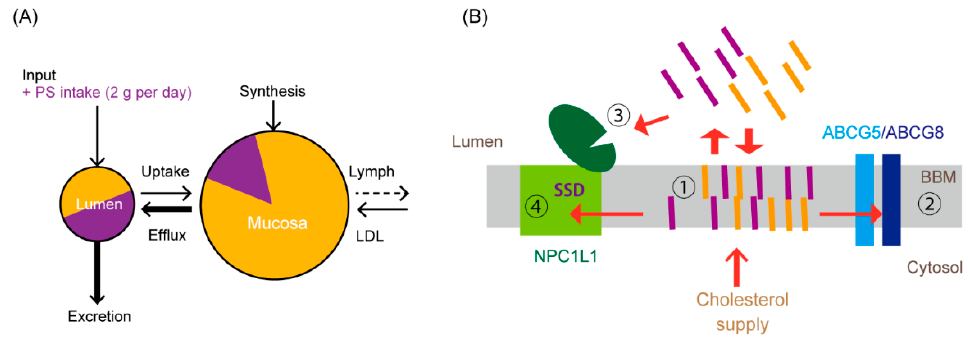
Figure 5. ( A ) Changes in cholesterol flux with plant sterol/stanol (PS) intake are shown in a simplified open compartment model in Figure 1F. Two grams of PS per day, which is recommended to reduce circulating LDL-C, could predominate in luminal sterols and is incorporated into the BBM (Mucosa). Lumen indicates the ratio of cholesterol to PS as 1:1, because approximately 2 g of cholesterol is supplied to the intestinal lumen per day in humans [15]. PS stimulates efflux, thus increasing total fecal neutral sterol excretion. These increased pathways are shown in bold arrows. PS in the mucosa and the lumen is indicated in purple as an image. ( B ) Possible effective sites of PSs for cholesterol absorption inhibition. The possible sites are indicated as ( 1 ) to ( 4 ) in the figure. ( 1 ), cholesterol (yellow bars) and PSs (purple bars) are taken up by the BBM, where the sterol capacity is limited. ( 2 ), ABCG5/G8 accepts both substrates [98]. ABCG5/G8 might be activated by PSs [54,97,99,100] and efflux more cholesterol concomitantly. ( 3 ), PSs might dilute cholesterol at the surface of the mucosa, reducing the chance to access to the binding site in the N-terminal domain of NPC1L1. ( 4 ), PSs can be mixed with cholesterol in the BBM, reducing the abundance of cholesterol in it and preventing the sterol-sensing domain (SSD) of NPC1L1 from sensing an increase in cholesterol. PSs may also compete with cholesterol for the binding site of the SSD.